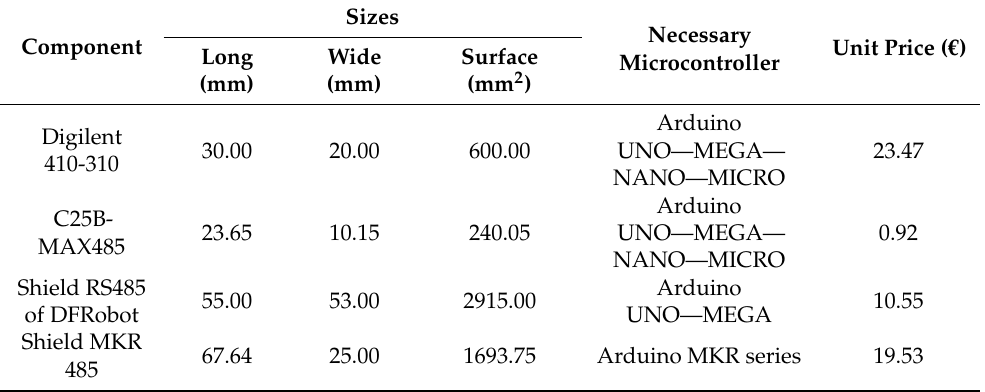
Table 4. RS485 components